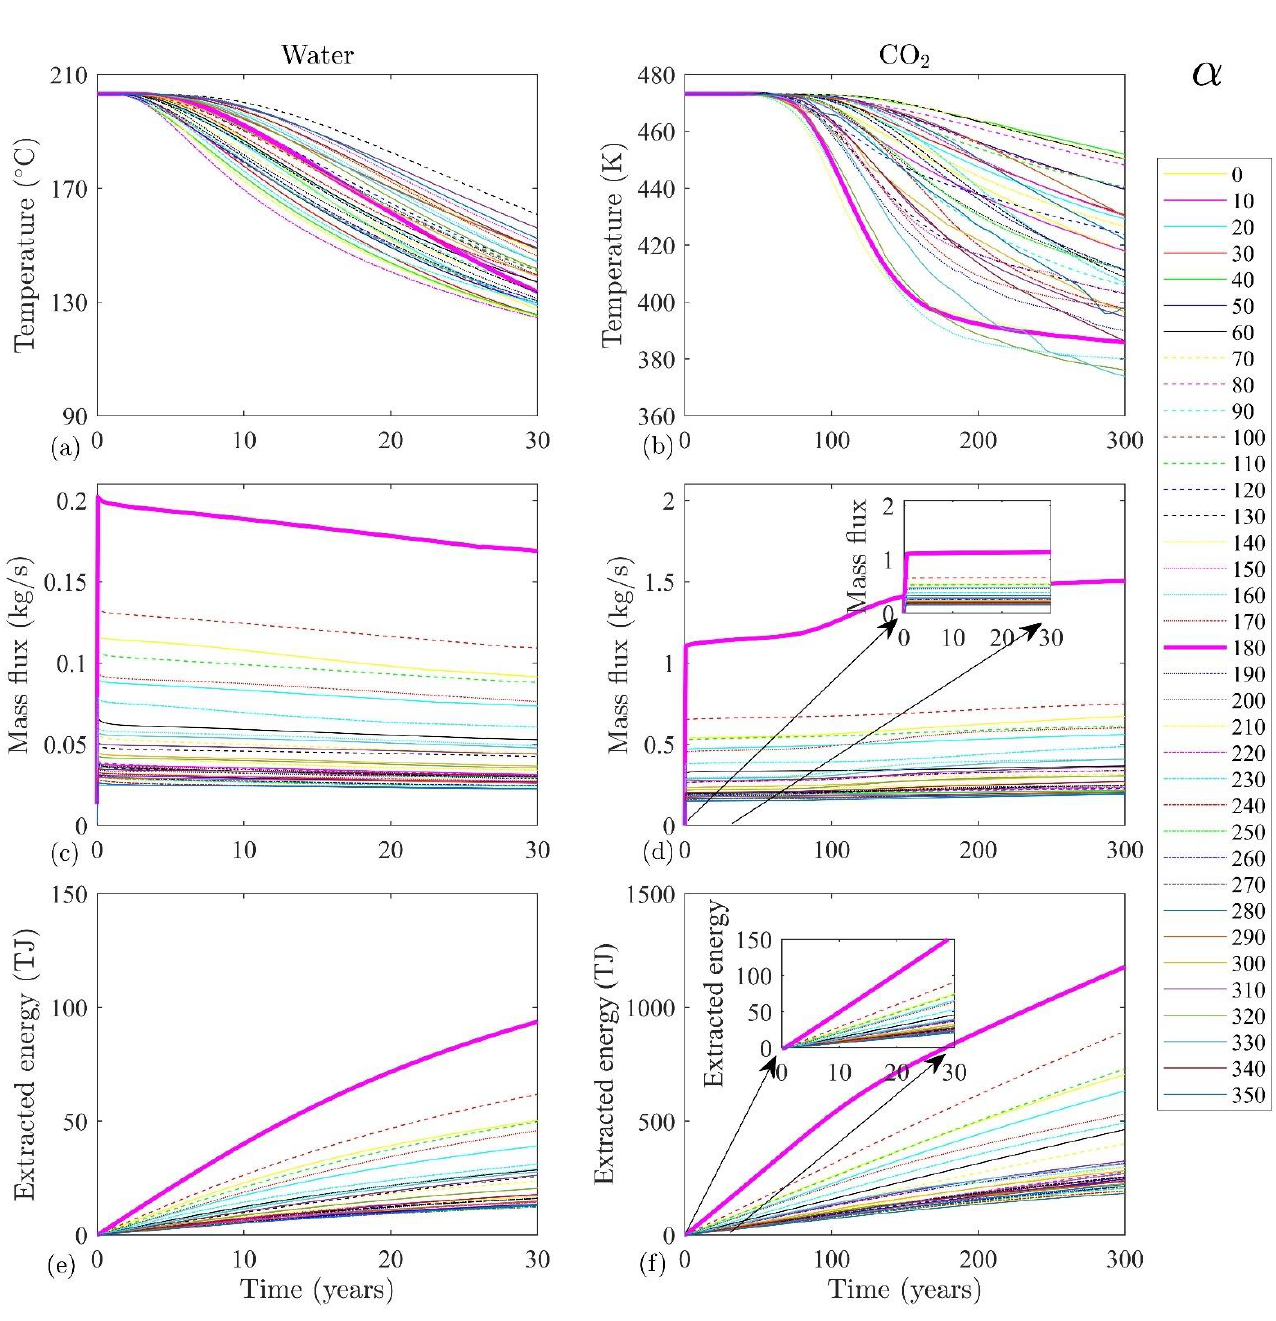
Figure 7. The temperature at the production well for ( a ) water and ( b ) CO 2 , mass flux at the production well for ( c ) water and ( d ) CO 2 , and cumulative energy extraction using ( e ) water and ( f ) CO 2 as heat-carrying fluid. Results from 36 simulation cases are plotted as shown by the legend, and case 180 is indicated by bold magenta color. Here Case 180 means injection well is present at 180, and production well is present at 0 (see Figure 2).